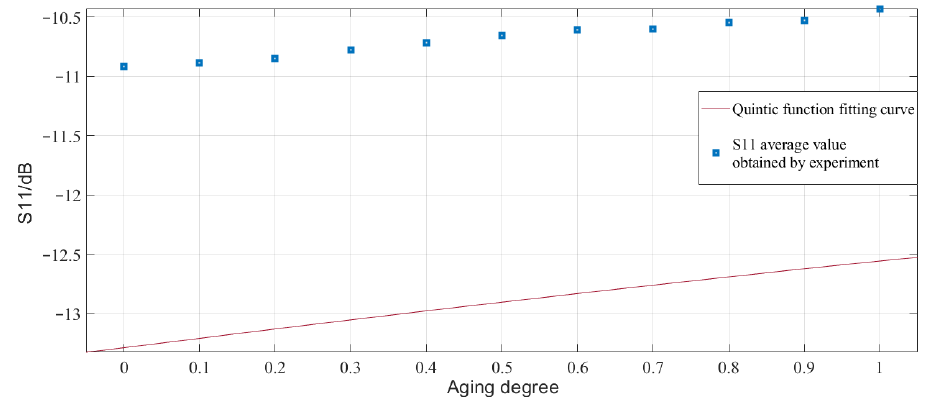
Figure 18. Comparison of experimental simulation results between aging degree and terahertz S11 parameters.